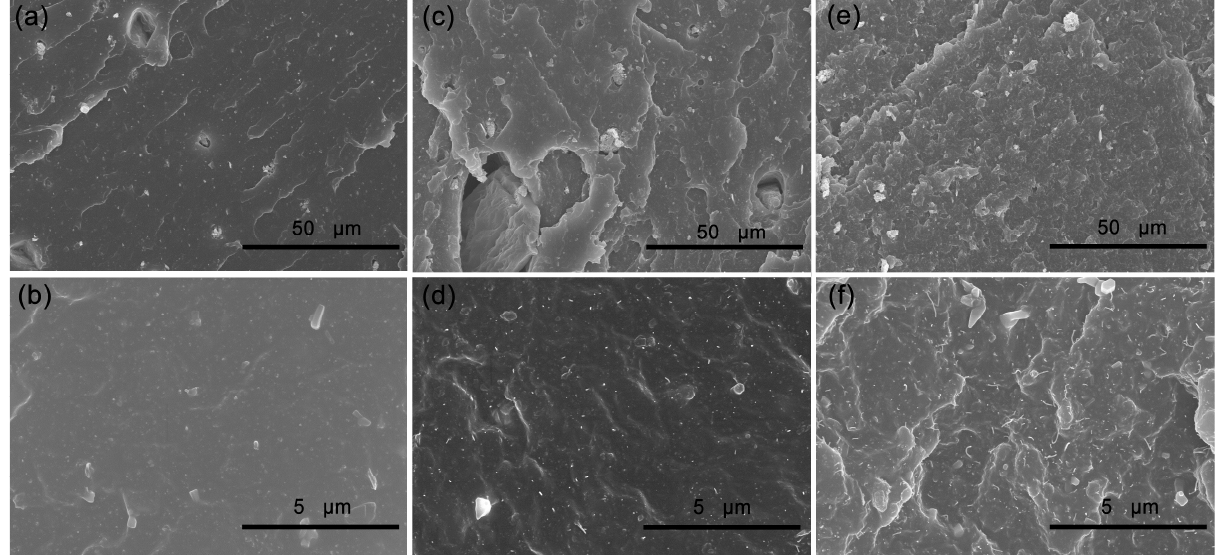
Figure 2. SEM images of tensile fractured surface for EPDM composites: ( a , b ) C0; ( c , d ) C4; ( e , f ) C10.